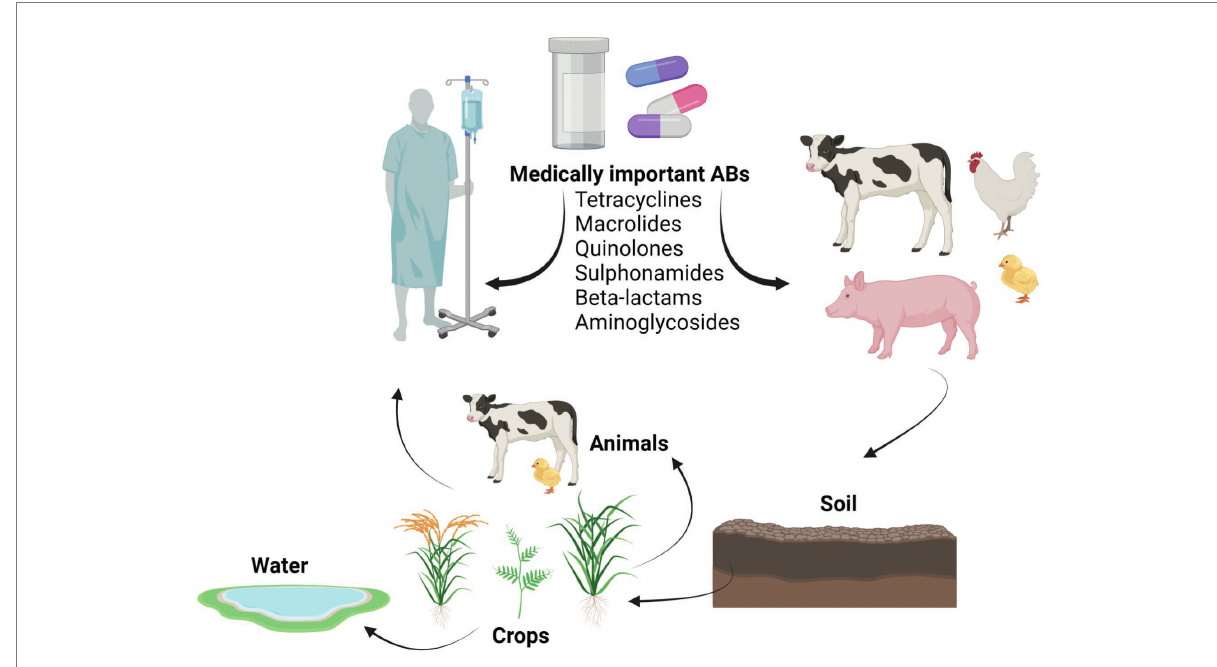
FIGURE 4 Contribution of manure to the flux of antibiotics from livestock to the natural environment. The figure is created using